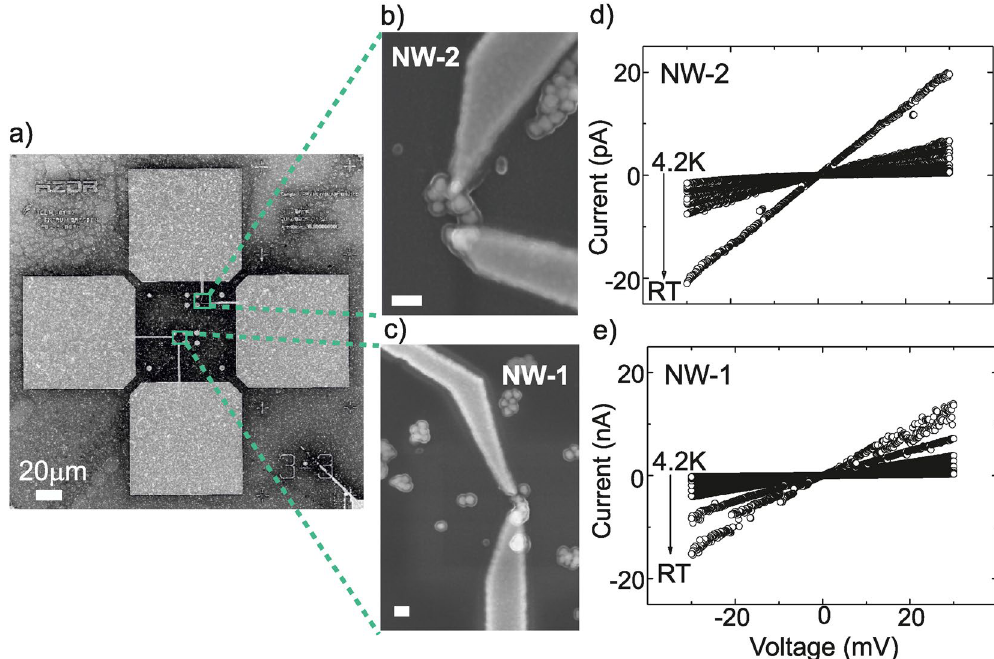
Figure 3. ( a ) SEM images of electrical contact pads and markers on SiO 2 / Si substrates. The markers are laid out on a square lattcie which define the “writing” fields (green squares) of 8 µ m x 8 µ m . ( b ), ( c ) Individual C-shape nanowires in between source and drain electrodes. Scale bars are 100 nm . ( d ), ( e ) Temperature dependent I - V characteristics from 4.2 K to RT of C-shape wires by biasing from − 30 mV to − 30 mV . The x-axis labels are identical for ( d ), ( e